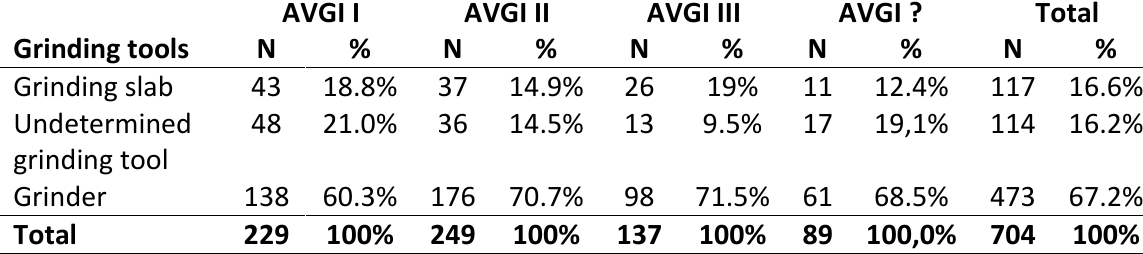
Table 2. Grinding tools frequencies and their distribution to the habitation